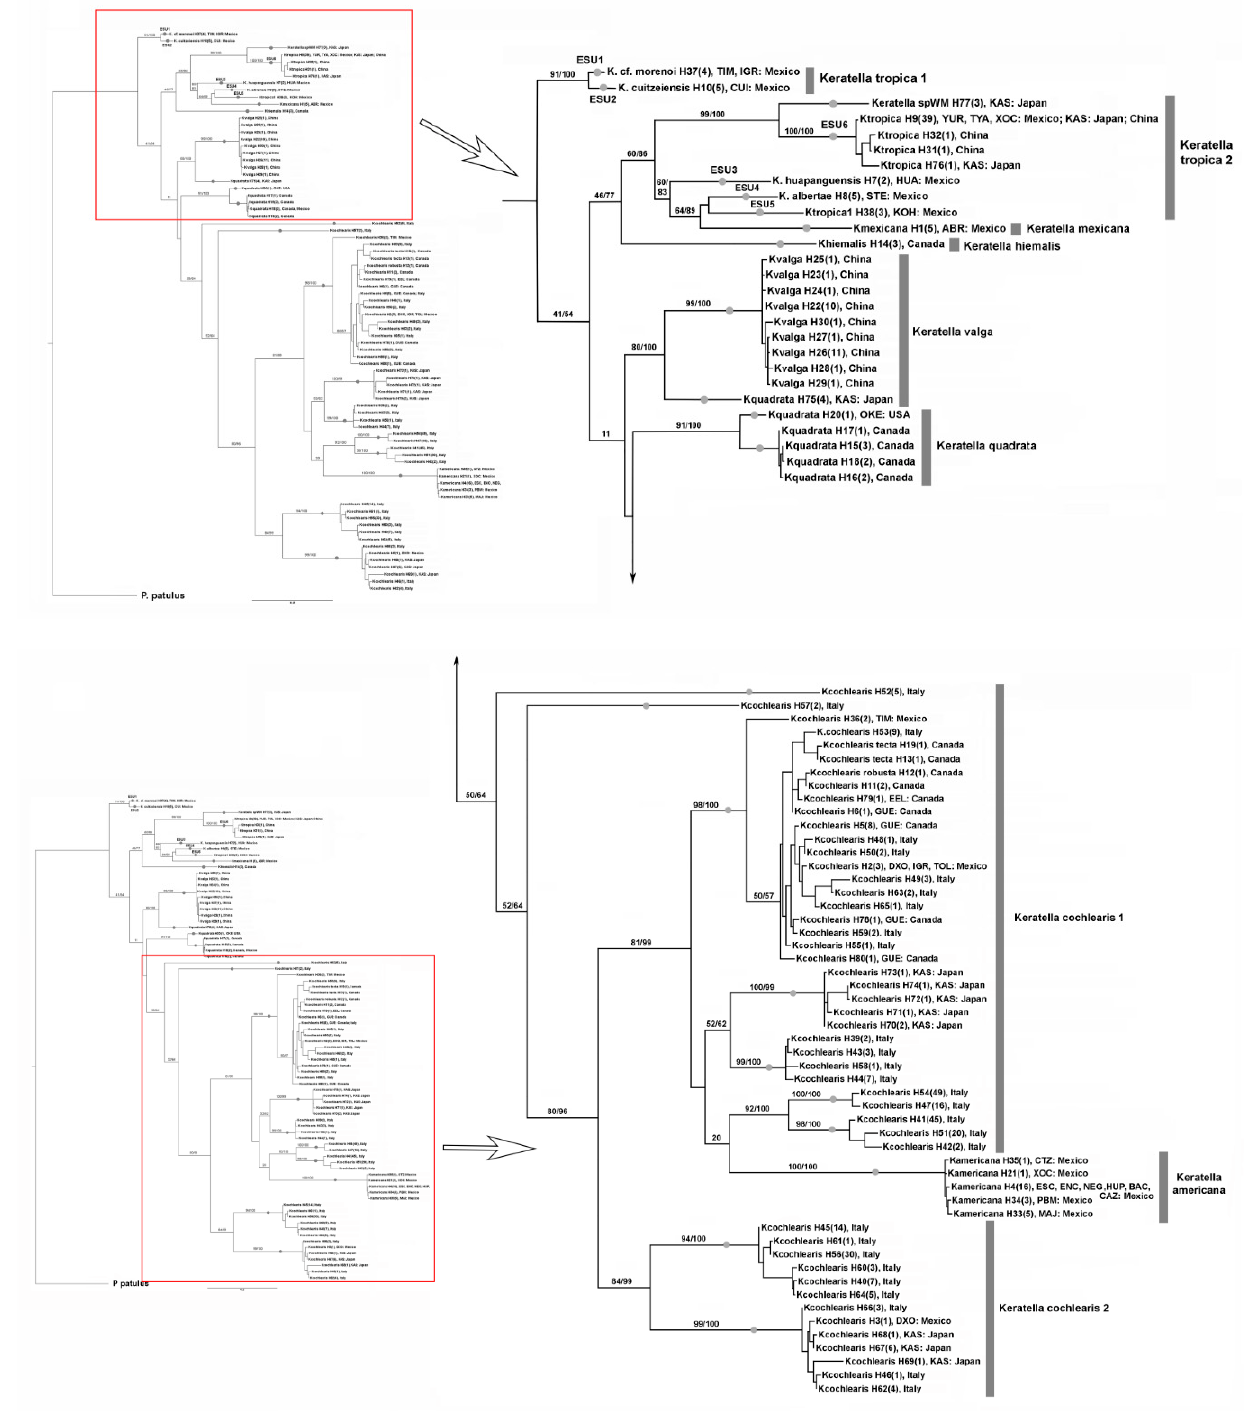
Figure 3. Maximum likelihood phylogram of the COI gene showing the relationship of the Keratella taxa. Haplotypes are accompanied by the number of individuals displaying that particular haplotype within parentheses and by the acronym of the water body or country in which they were isolated (when the information is available). Numbers on major branches are the percentages of branch support in the Maximum likelihood (bootstrap) and Bayesian (posterior probability) analyses respectively. Dark bars indicate that haplotypes are part of a Keratella group. Dark circles over branches indicate a putative species delimited by all the species delimitation methods.